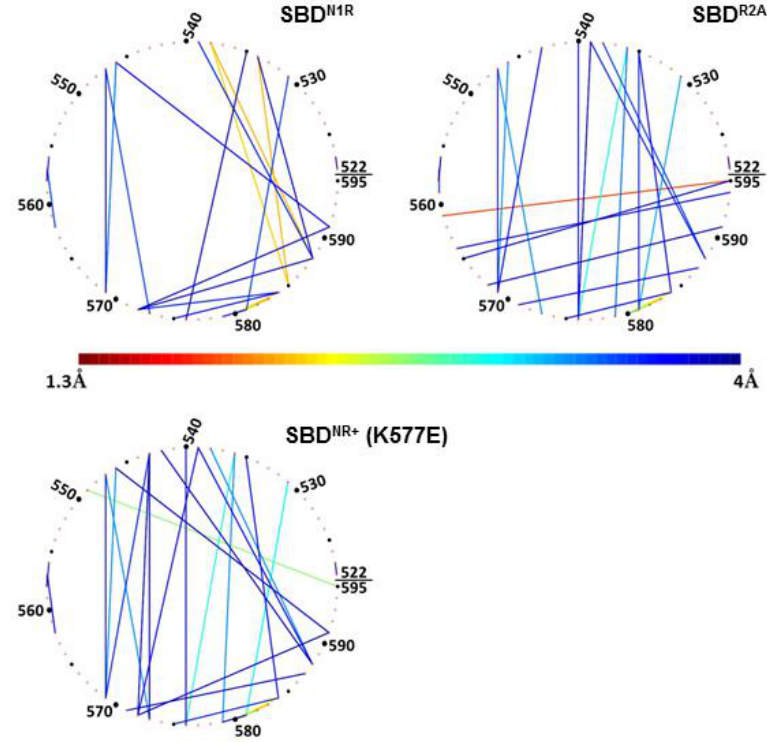
Figure 8. Interconnectivity network between helices B, C and D in SBD N1R , R2A and SBD NR+ (K577E) simulations. Each panel shows the geometric mean of the minimal distance between two residues during the last 10 ns of the simulation. The color of the connecting lines represents the mean distance according to the color bar. Only pairs for which the mean distance is less than 4 Å are